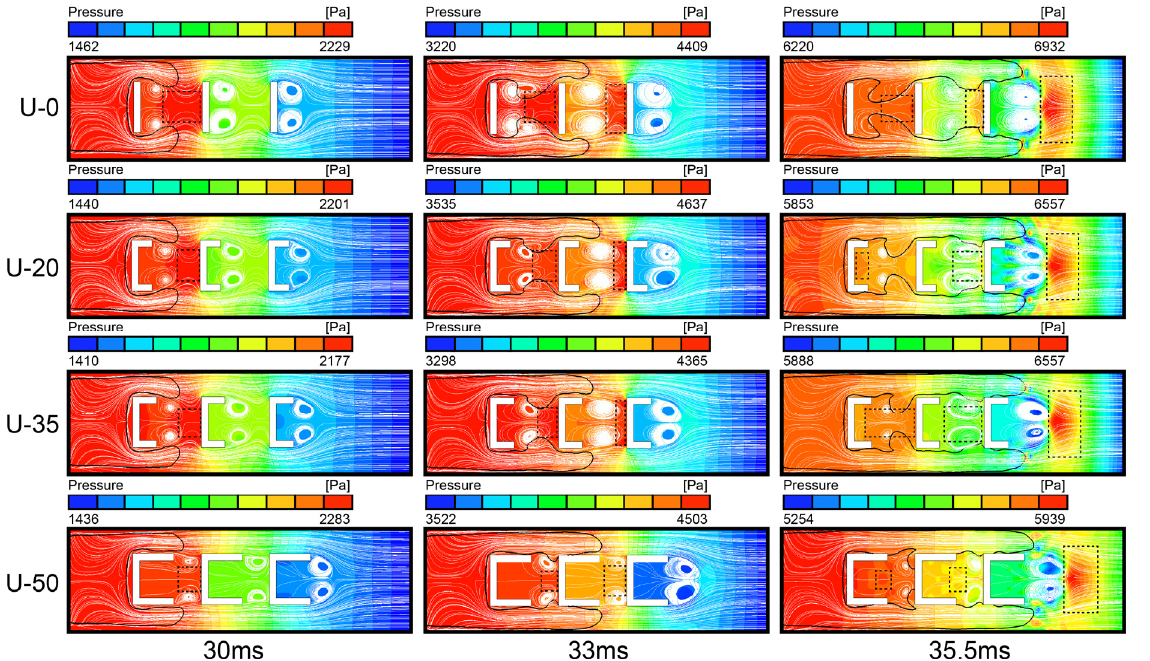
Figure 6. The coupling relation of pressure, velocity and flame propagation. Some unique structures of reverse flow were formed between the adjacent plates because of the influence on the vortex and high-pressure areas when the flame front position passed the obstacles, which was the result of the coupling function of the vortex and high pressure. However, these structures gradually decreased and even faded away with the increasing height of the U-type plates, as shown at 35 ms in Figure 5. When the height increased, the areas influenced by high pressure and the pressure values decreased with the decreased height at the same time because the influence of unburned premixed gas was gradually decreased, such as in the annotated areas at 30 ms and 33 ms. The flame of reverse flow continually burned those unburned premixed gases and caused those unburned gases to be compressed and combusted. Therefore, the created high-pressure areas could move toward the reverse direction of the flame propagation, as the annotated rectangles at 33 ms and 35 ms in the U-20 show. However, the phenomenon of moving high pressure didn’t appear in U-20, which related to the height of the U-type. This is because the flame in the U-0 plates bent to the space between two plates and the unburned premixed gases were also combusted by the flame front tip. Those spaces with high pressure can not create the pressure gradient, and the high-pressure areas cannot move toward the back. When the flame surface entirely passed all plates, the high-pressure field of the flame front position moved toward the opening of the closed tube with the increase of height of the U-type plates, such as in those annotated areas at 35.5 ms.